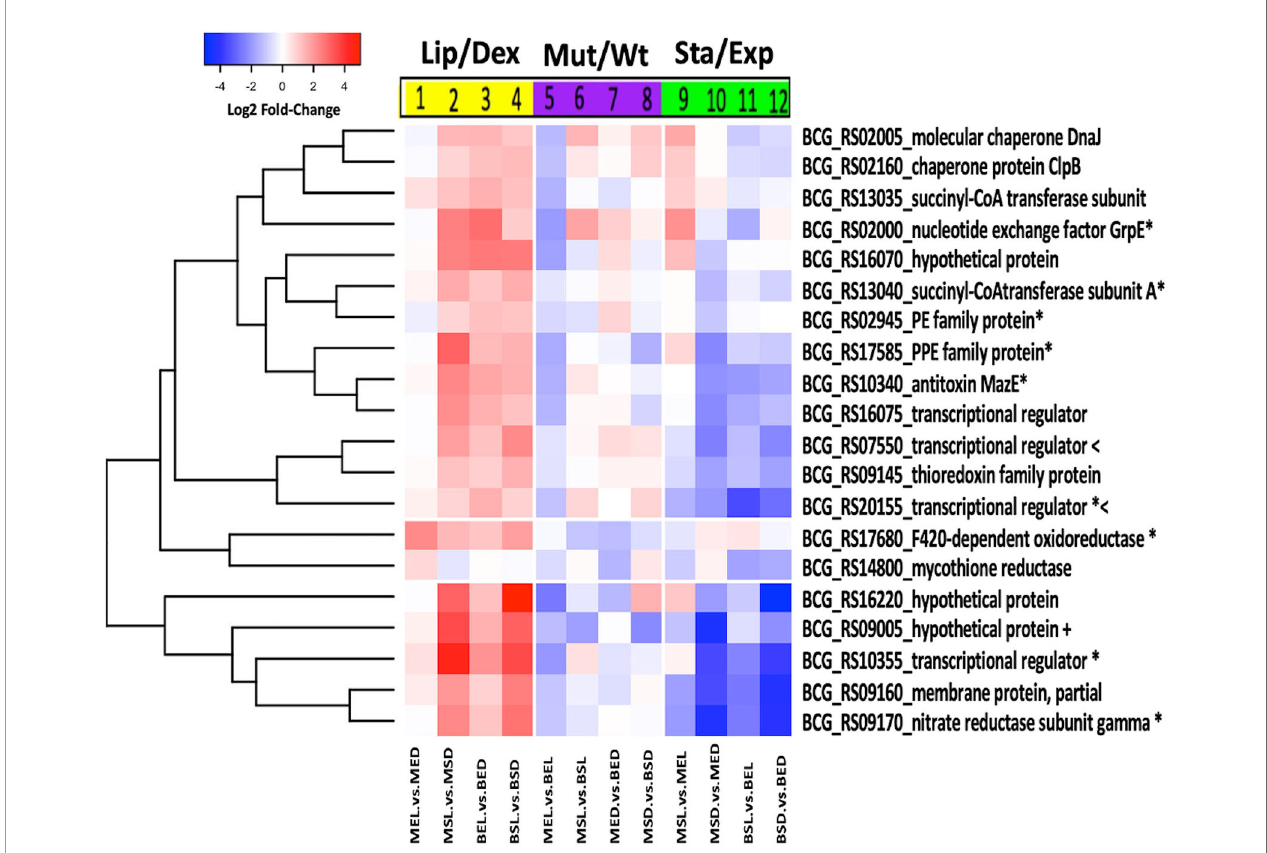
FIGURE 3 | Expression patterns of M. bovis BCG lipid signature genes. Log2 fold-change values of each of the 20 genes of the lipid signature for M. bovis BCG are observed under three different analyses: lipid effect (yellow block), BCG_2177c mutation effect (purple block), and growth phase effect (green block). All experiments were performed as previously described in the methodology section. wtBCG or mtBCG strains cultured in dextrose or lipids during exponential (BED, wtBCG dextrose; BEL, wtBCG lipids; MED, mtBCG dextrose; MEL, mtBCG lipids) or stationary phases (BSD, wtBCG dextrose; BSL, wtBCG lipids; MSD, mtBCG dextrose; MSL, mtBCG